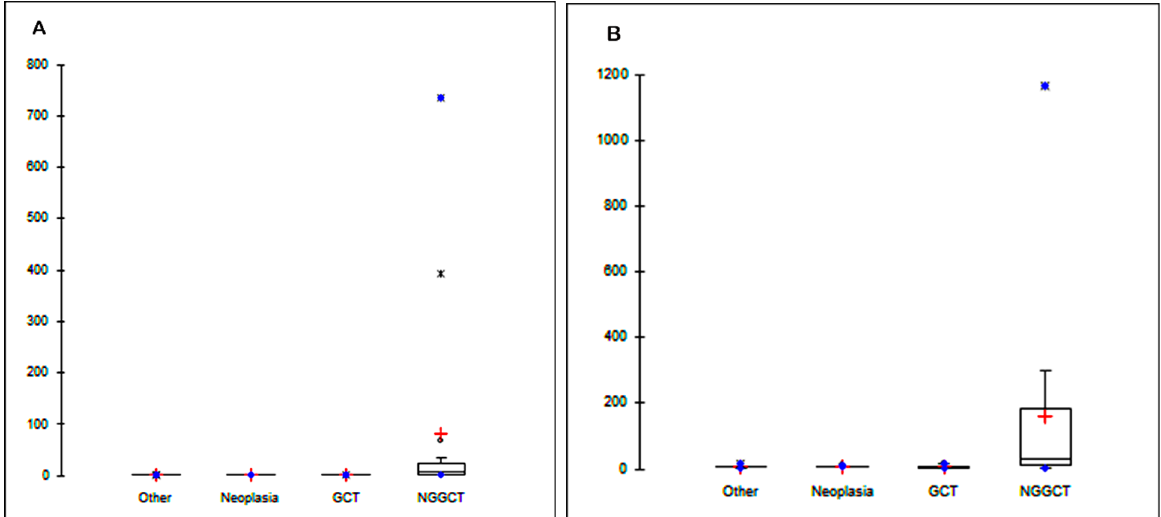
Figure 1. Cerebrospinal fluid (CSF) level of alpha-fetoprotein (AFP) ( A ) and human chorionic gonadotropin (hCG) ( B ) in patients affected by non-cancerous diseases (Other), other brain tumors (Neoplasia), germinoma (GCT), and non- germinomatous germ cells tumors (NGGCT). Dot plots show mean CSF concentrations (ng/mL) of AFP and hCG. * indicates p -values < 0.050 (Kruskal–Wallis test followed by multiple comparison of mean